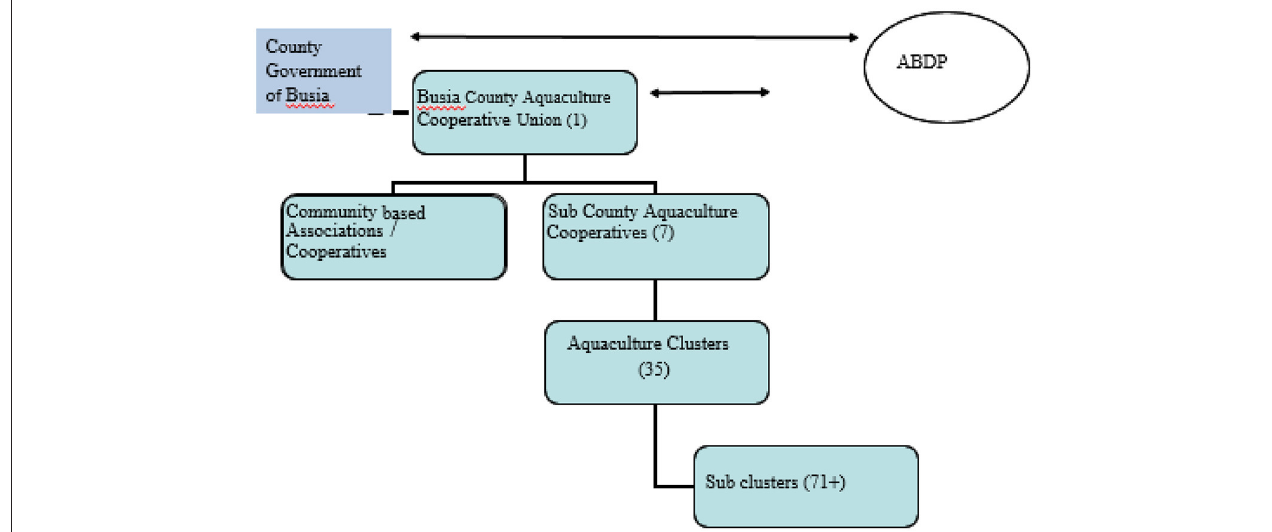
FIGURE 5 | The Aquaculture marketing support organization structure in Busia County.